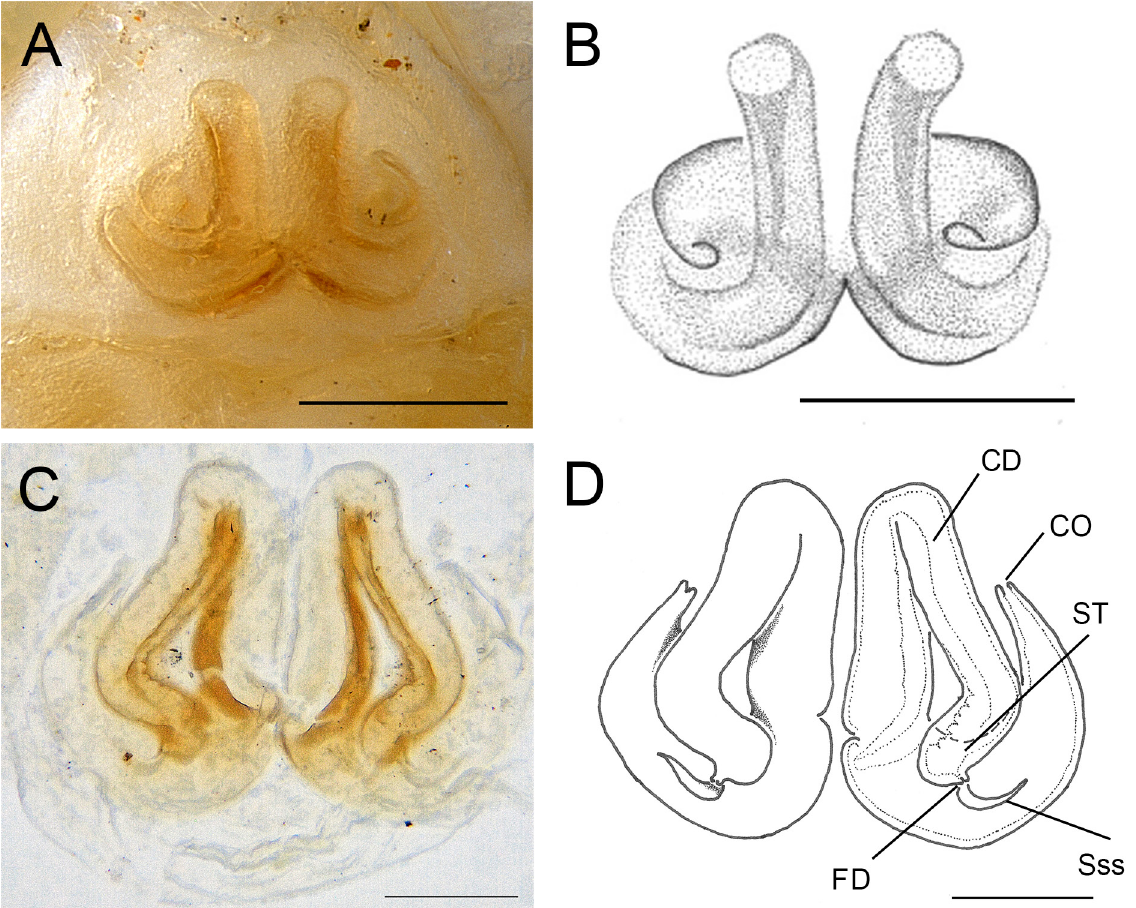
Fig. 7. Andromma albinovani sp. nov., ♀, paratype (BE_RMCA_ARA.Ara 177497). A–B . Epigyne, ventral view. C–D . Same, cleared, dorsal view. Abbreviations: CD = copulation duct; CO = copulatory openings; FD = fertilisation duct; Sss = sickle-shaped sclerite; ST = spermathecae. Scale bars: A–B = 0.2 mm; C–D =